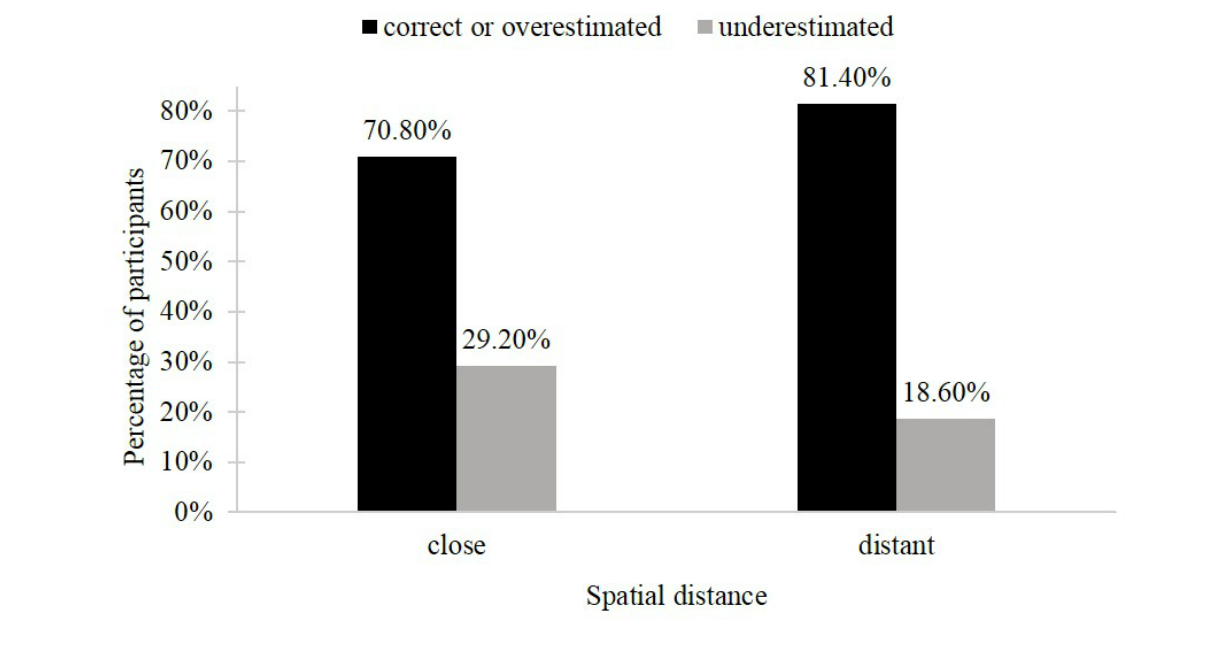
Figure 3. Recall of the small loss in the mixed-gain outcome conditions.